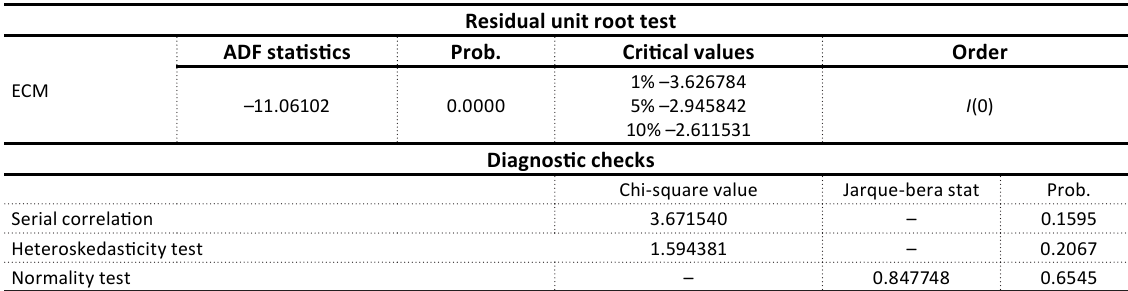
Source: Authors’ compilation